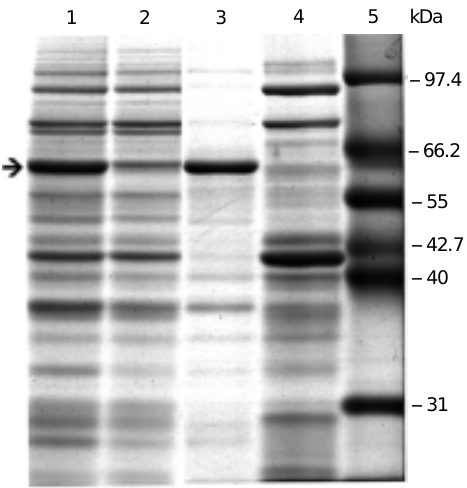
kDa.Figure 1 - Polyacrylamide gel (10% acrylamide) stained with Coomassie blue showing the localization of re- combinant PLC-a expressed from pET23a. Lane 1 , E. coli BL21(DE3) transformed with pET23a harboring a PLC-a ORF - whole cell extract after sonication. Lane 2 , Sonicated extract supernatant. Lane 3 , Sonicated ex- tract pellet. Lane 4 , Periplasmic fraction proteins. Lane 5 , Mid-range protein molecular weight marker (Promega). The arrow shows the